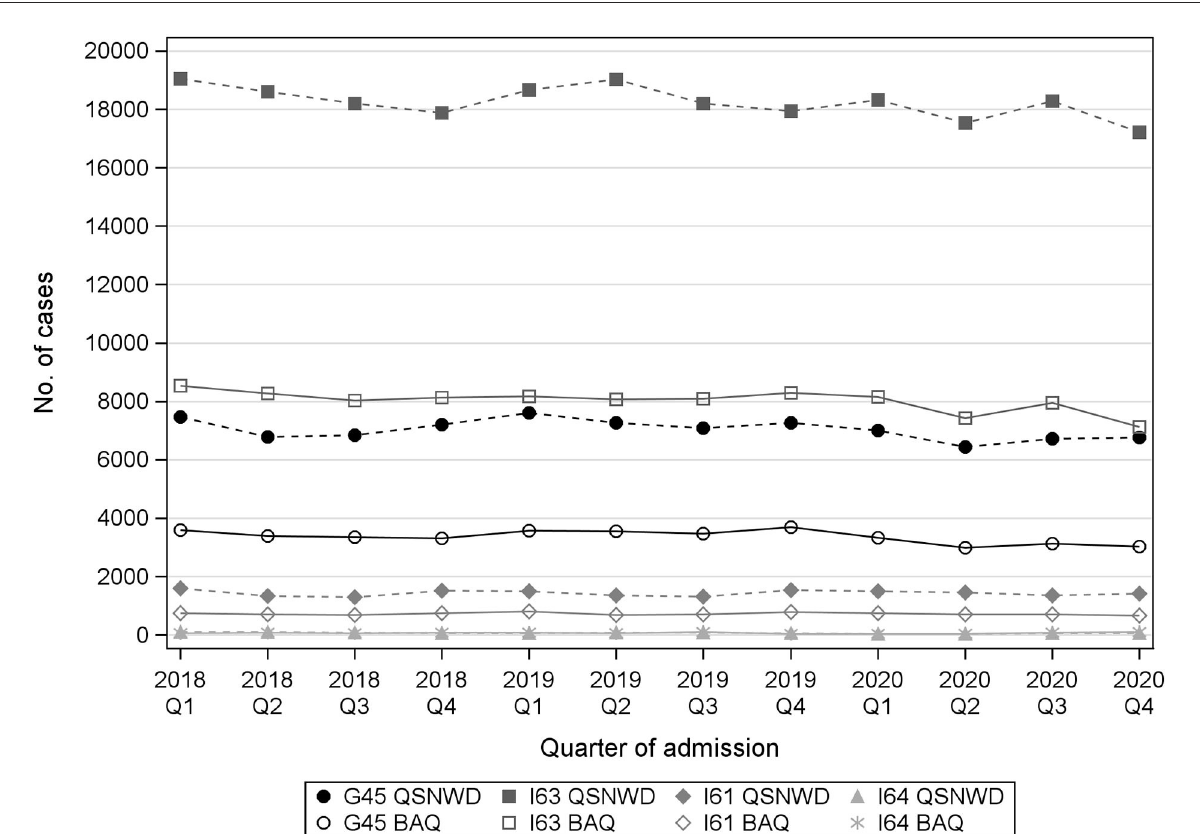
FIGURE1 Number of cases with transient ischemic attack (ICD-10 G45), cerebral infarction (ICD-10 I63), cerebral hemorrhage (ICD-10 I61), or stroke, not specified as hemorrhage or infarction (I64) from the registries QSNWD (dashed lines) and BAQ (solid lines) in 2018–2020 by quarter of admission.